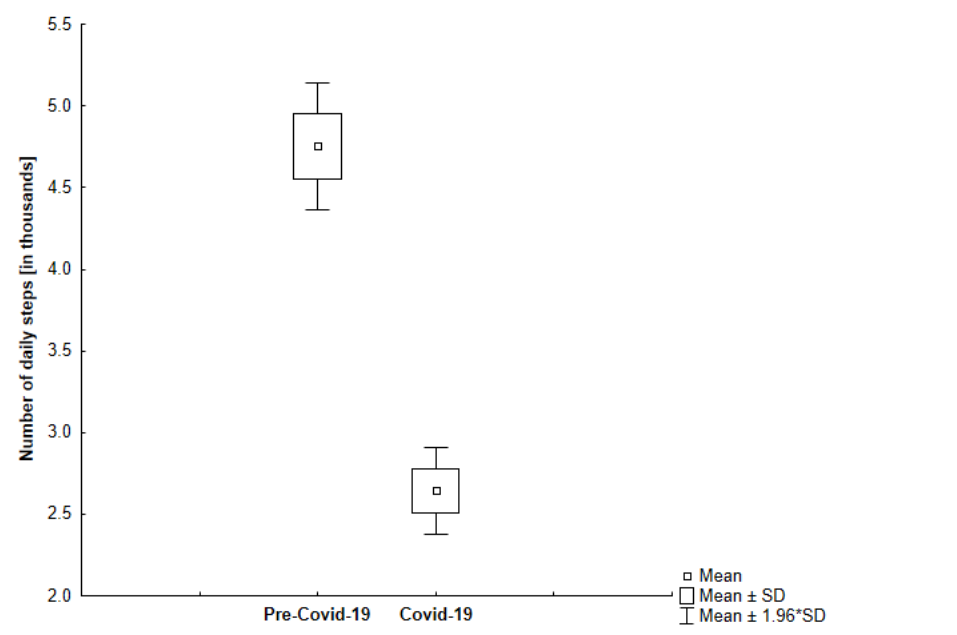
Figure 4. The comparison of the number of daily steps in the analyzed periods among older participants ( p < 0.001).